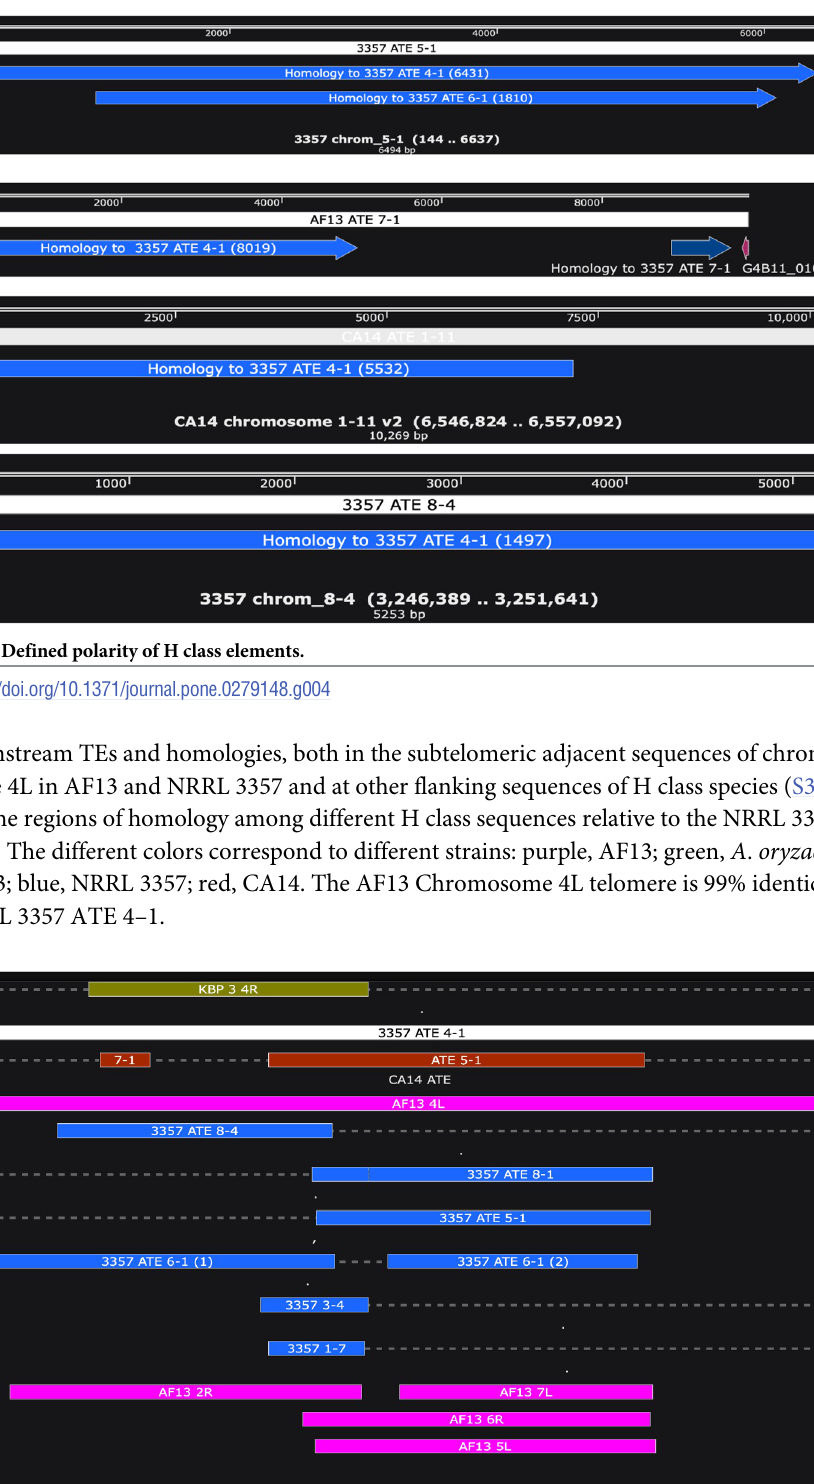
Fig 5. Relative positions of H class